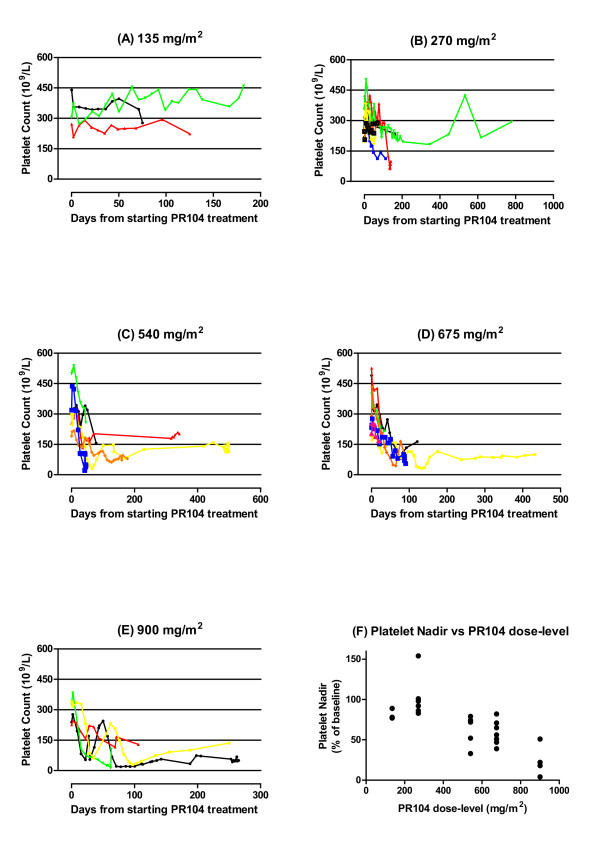
PR-104-induced thrombocytopenia followed until death or further treatment. (a) Time-course of thrombocytopenia in each subject at 135 mg/m2 (b) Time-course of thrombocytopenia in each subject at 240 mg/m2 (c) Time-course of thrombocytopenia in each subject at 540 mg/m2 (d) Time-course of thrombocytopenia in each subject at 675 mg/m2 (e) Time-course of thrombocytopenia in each subject at 900 mg/m2 (f) Platelet nadir on first treatment cycle correlated with PR-104 dose-level (Spearman r = -0.79; P < 2 × 10-7).